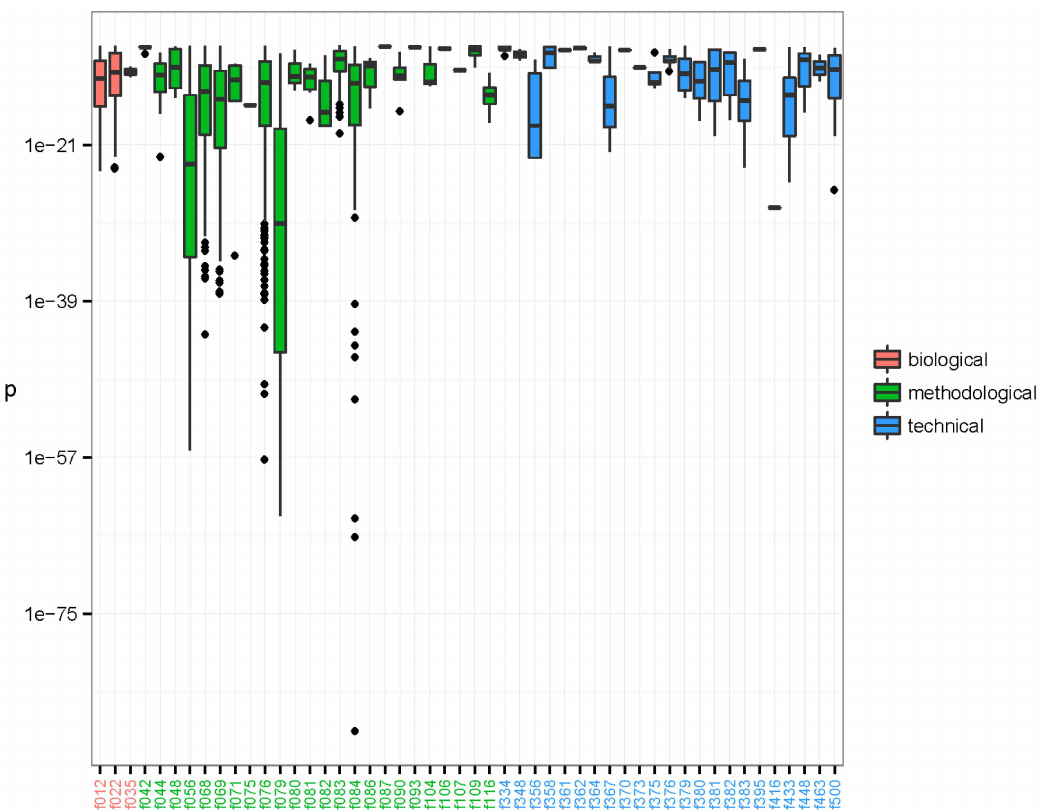
Figure 3. Lowest p -values of clusters established by the pipeline. The p -values are arranged by feature of the strongest significant association of each of the 6165 clusters. The 50 features involved as strongest associations have been coloured by type: biological (red), methodological (green), and technical (blue). The boxes span the first and third quartiles. The dark band inside each box represents the median. The whiskers of the boxes extend to the lowest and highest values within a distance of 1.5 times the interquartile range. As can be seen, most p -values were above 1e-24, but a few methodological